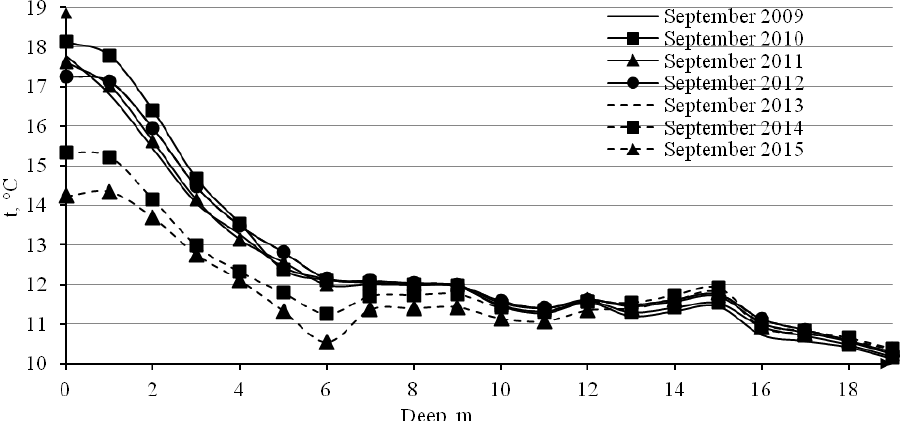
Figure 3. Site 1. Diagram of average monthly temperatures of soil mass in September for the 2009-2015